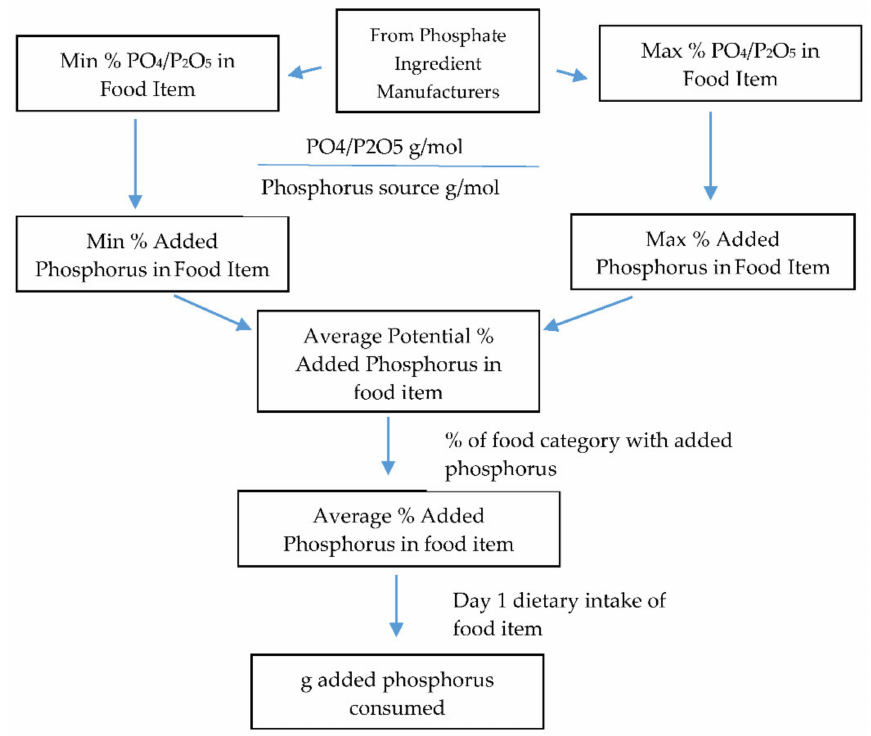
Figure 1. Process of calculating values of added phosphorus in foods and